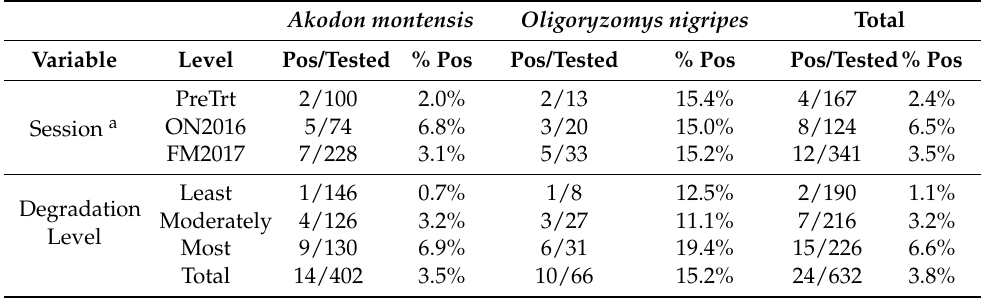
Table 3. Hantavirus seroprevalence by sampling session and degradation level.